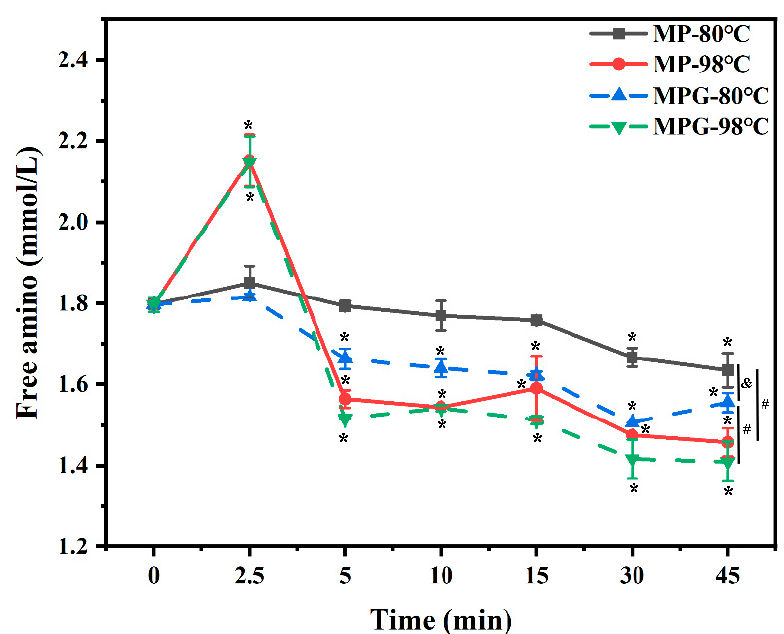
Figure 9. Changes in free amino content of myofibrillar protein and glucose (MPG) and myofibrillar protein (MP) under different heating conditions (80 °C and 98 °C, 0 − 45 min). Error bars indicate standard deviation (n = 3). Samples with * p < 0.05 indicate significant differences at different heating times (compared with 0 min). Samples with # p < 0.05 indicate significant differences between 80 °C and 98 °C. Samples with & p < 0.05 indicate significant differences between MPG and MP.